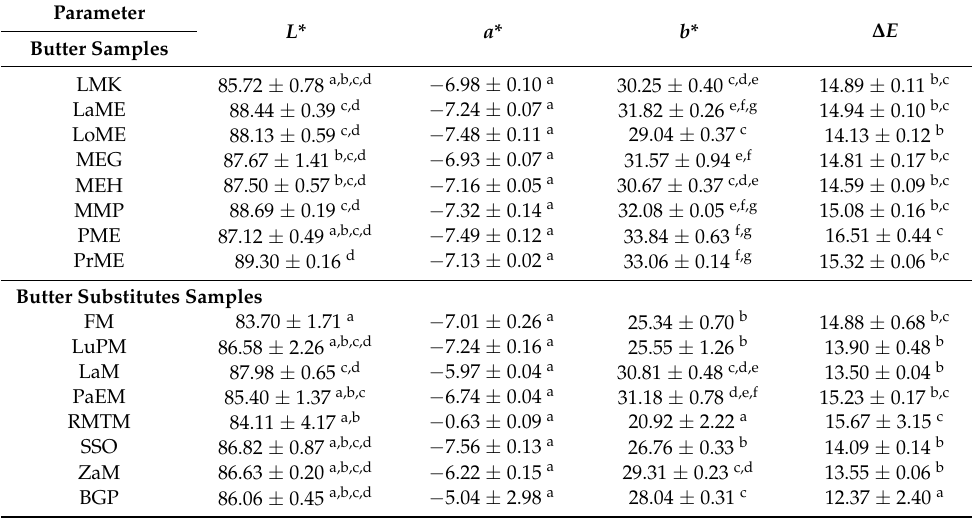
Table 6. Color components of butter and butter